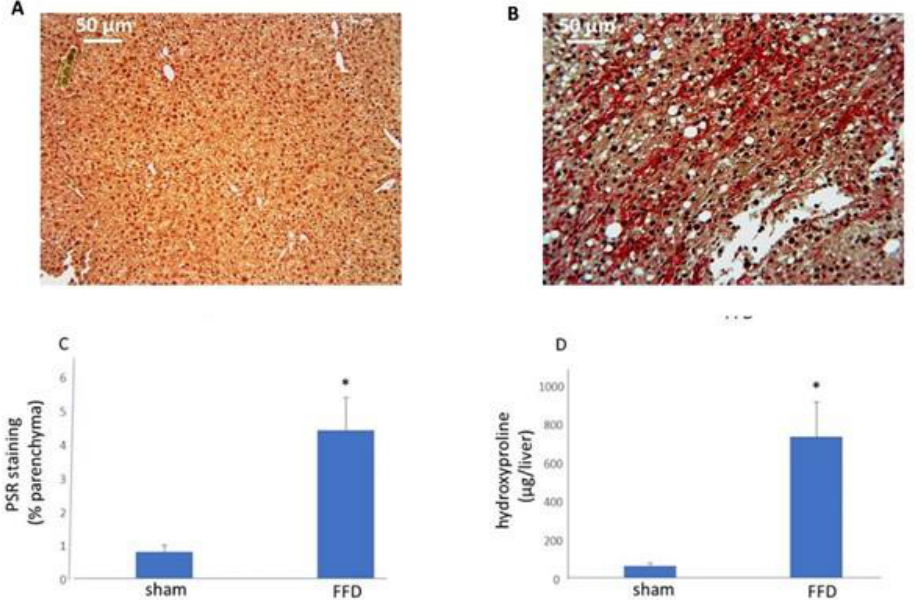
Figure 2. NASH accompanied by liver fibrosis. Representative images of PSR-stained liver sections from mice randomized to a standard diet: ( A) sham; ( B ) FFD, with increased staining in the latter. ( C ) Matrix deposition had increased in the FFD cohort relative to the sham cohort. ( D ) Livers from the FFD cohort had an elevated level of hydroxyproline. *, p < 0.01.